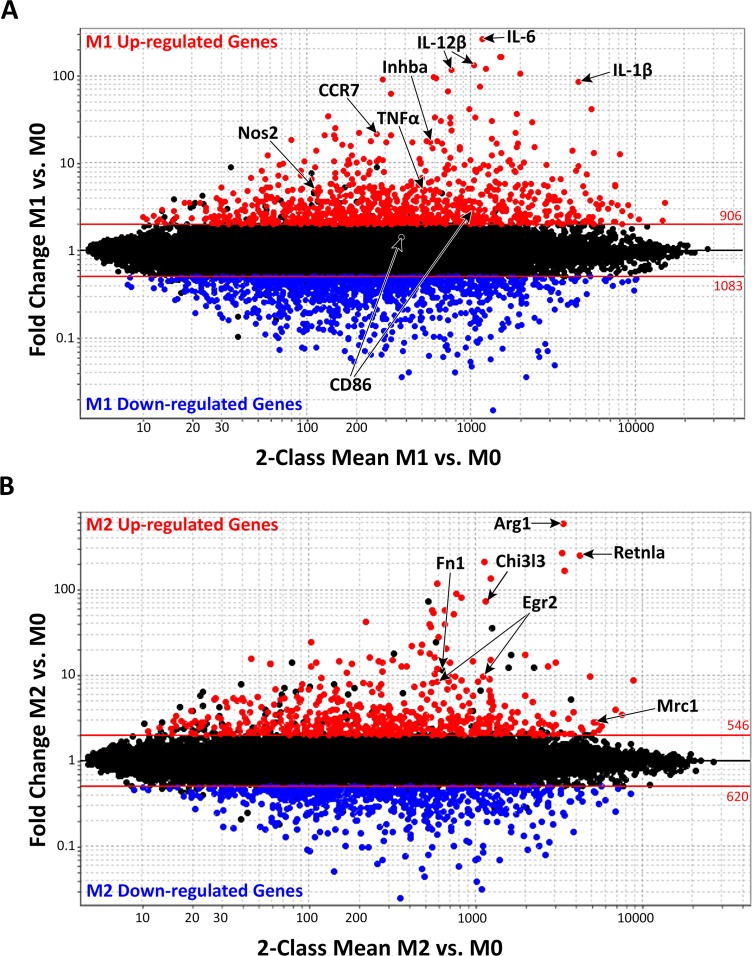
Macrophage signature in classically activated M1 and alternatively activated M2 macrophages.Fold Change (FC) vs. Mean Expression Value (MEV) plot of microarray data highlighting 2 FC or higher up-regulated genes (red, p≤0.05) or down-regulated genes (blue, p≤0.05) in (A) classically activated M1 macrophages (compared to M0 condition) or (B) alternatively activated M2 macrophages (compared to M0 condition). Red lines represent a ± 2FC cut-off. The numbers above and below the lines indicate the number of probes (some genes are represented by several probes and, hence, as several dots) above or below the 2 FC cut-off, respectively. Genes previously associated with classical and alternative macrophage phenotypes are labeled with corresponding gene names. Genes associated with (A) classically activated macrophages include Nos2, CCR7, TNFa, Inhba, IL12b, IL-6, and IL-1b, and CD86. Genes associated with (B) alternatively activated macrophages include Arg1, Fn1, Egr2 (human), Mrc1/CD206, Chi3l3/Ym1 and Retnla/Fizz-1.